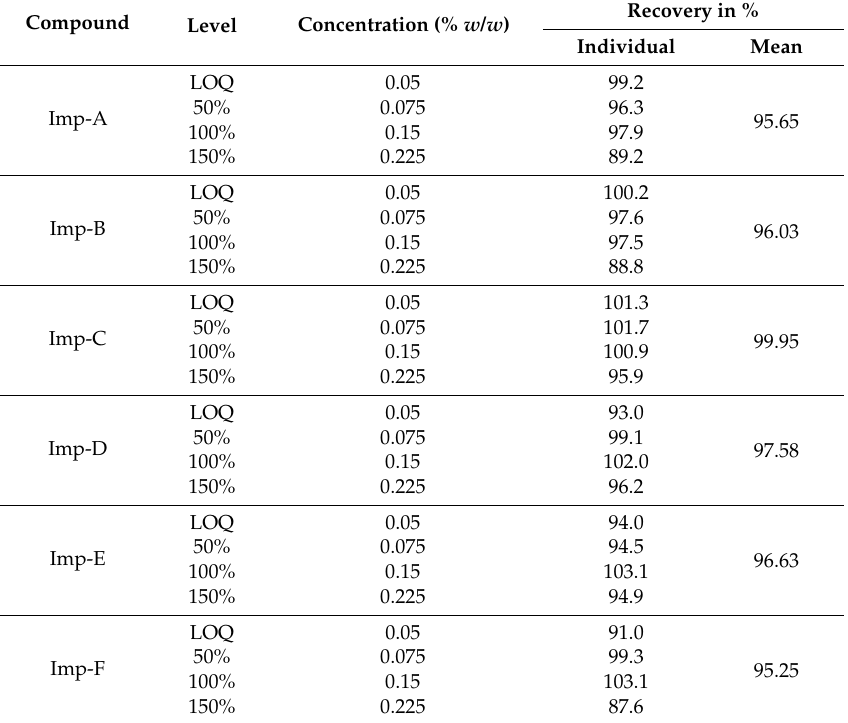
Table 6. Results of accuracy for related